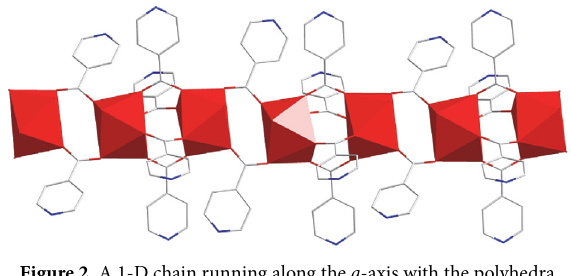
Figure 2. A 1-D chain running along the a -axis with the polyhedra representing the DyO 8 moieties